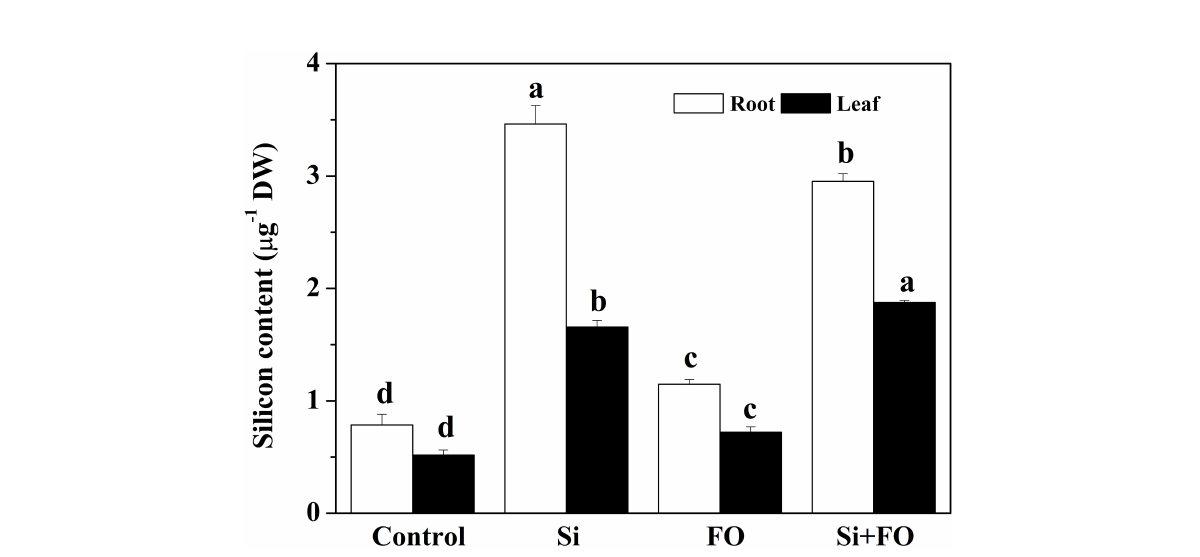
FIGURE 10 Effects of exogenous silicon application on endogenous silicon content in cucumber plants. Means denoted by the different lowercase letters are signi fi cantly different according to Tukey ’ s test ( P ≤ 0.05); the mean represents the average of three replicates ± standard deviation (SD). Control: plants were irrigated with sterilized water; Si: plants were irrigated with exogenous silicon (3 mmol·l -1 Si); FO: plants were only inoculated with Fusarium ; Si+FO: plants were irrigated with exogenous silicon followed by inoculation with Fusarium.